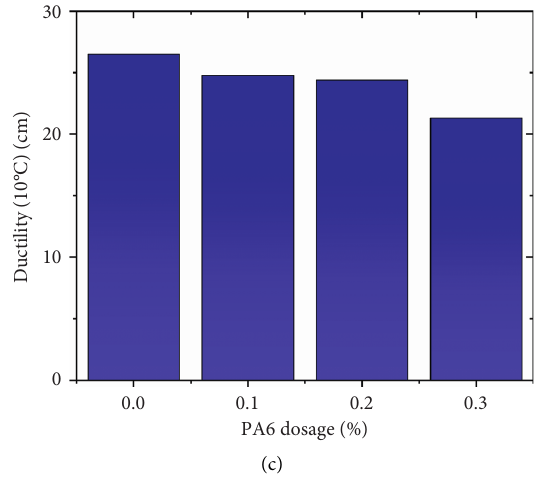
Figure 6: Physical properties of PA6-modified asphalt and 70# asphalt.